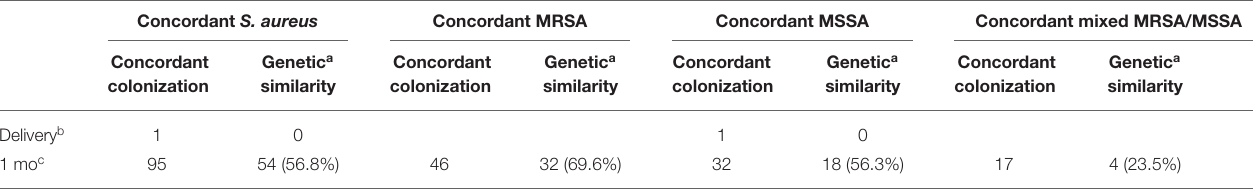
TABLE 1 | Molecular relatedness of concordant colonization with Staphylococcus aureus in infant-mother pairs. Concordant S. aureus Concordant MRSA Concordant MSSA Concordant mixed MRSA/MSSA Concordant Genetic a Concordant Genetic a Concordant Genetic a Concordant Genetic a colonization similarity colonization similarity colonization similarity colonization